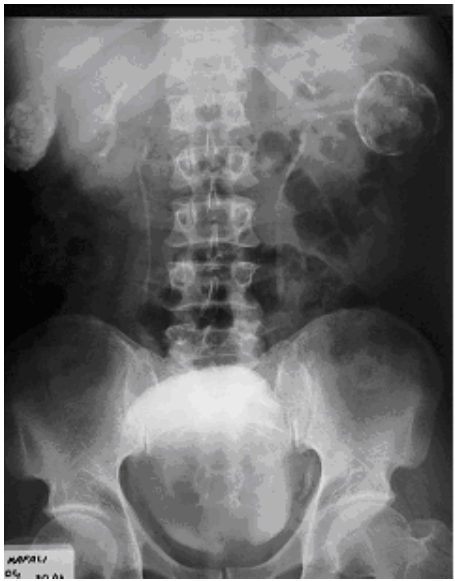
FIGURE 1 . Multiple calcified lesions and functional kidneys on IVU.